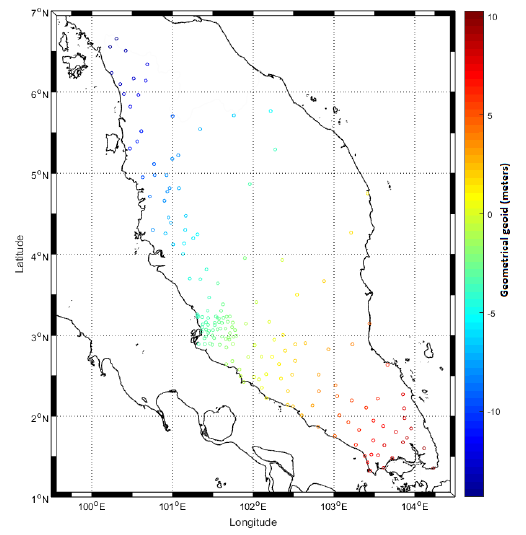
Figure 11 Distribution of GNSS leveling points